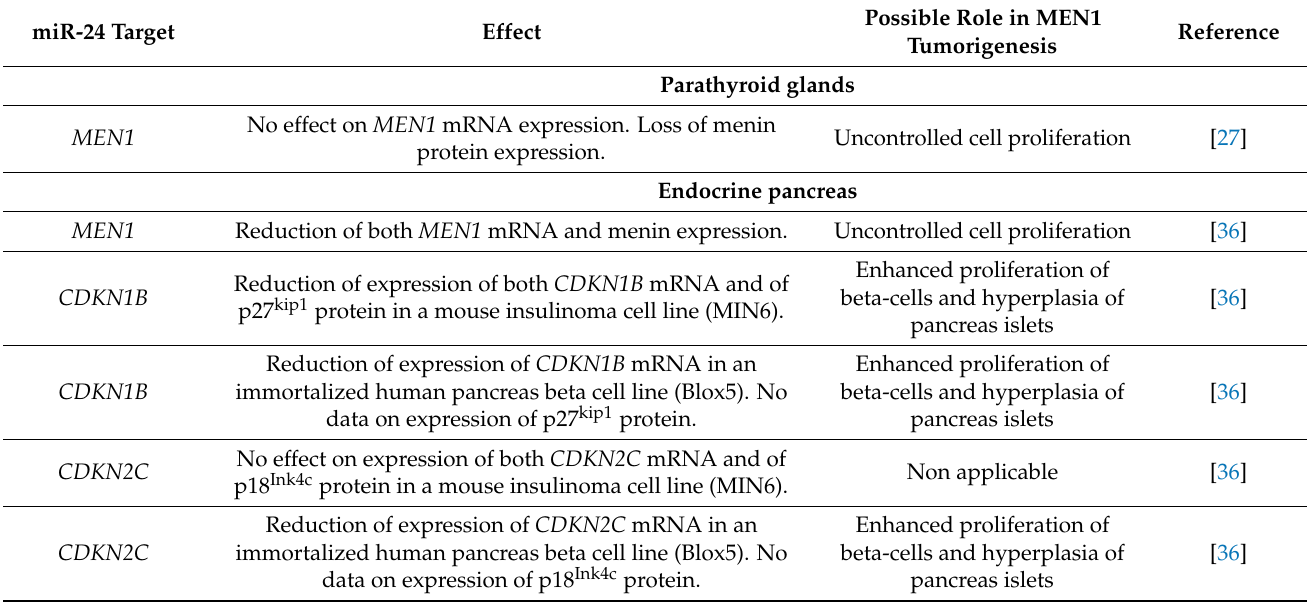
Possible Role in MEN1 Reference Tumorigenesis Parathyroid glands